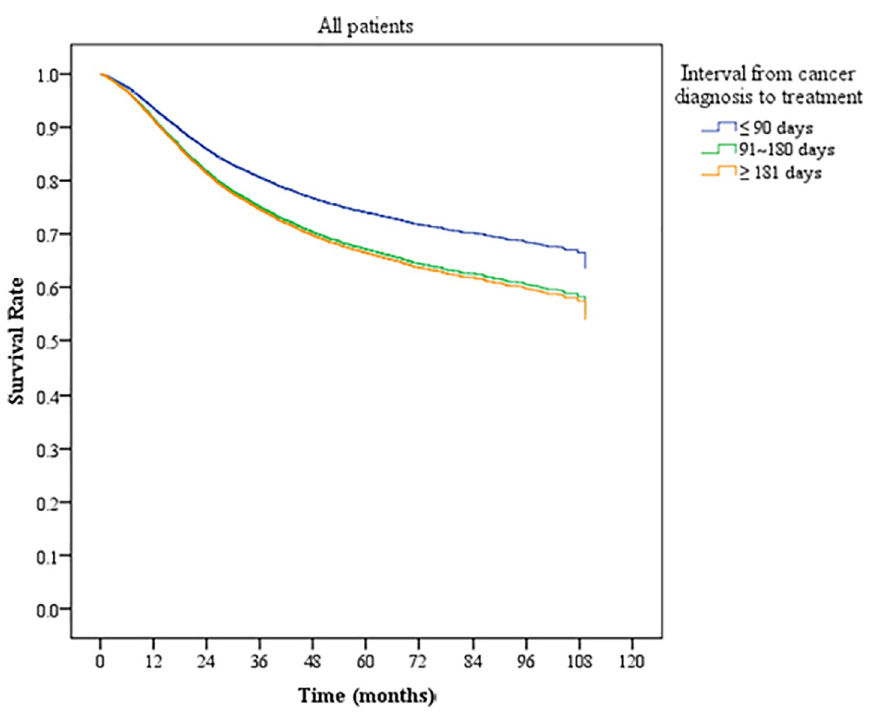
Fig 1. Kaplan–Meier curves of cervical cancer patients with different cancer